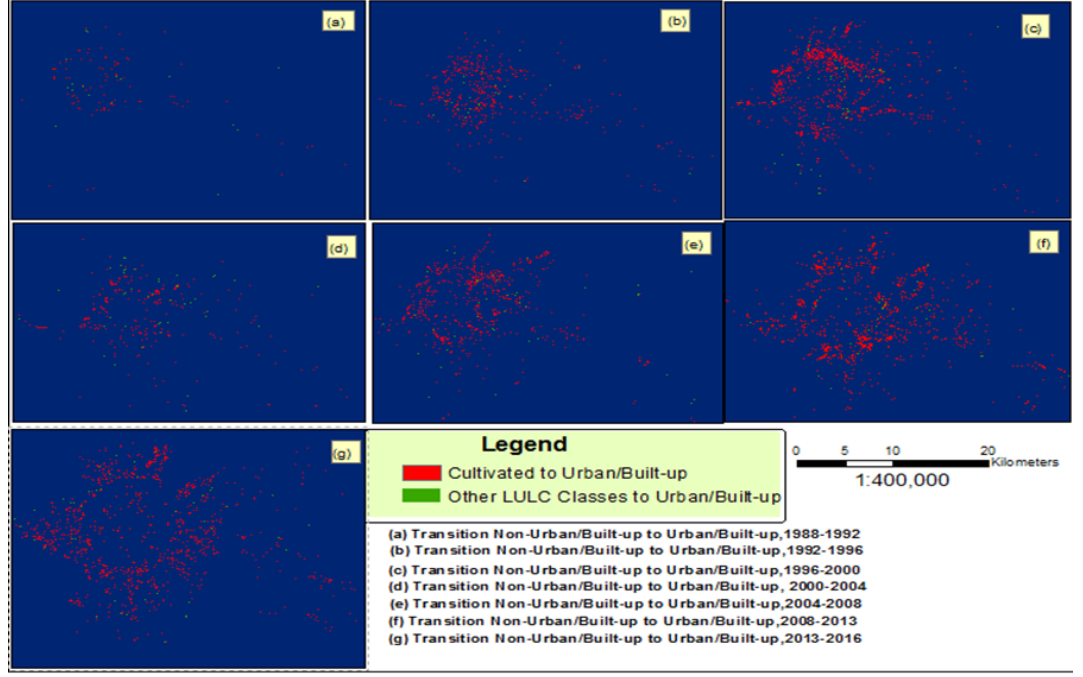
Figure 6. Transition map.